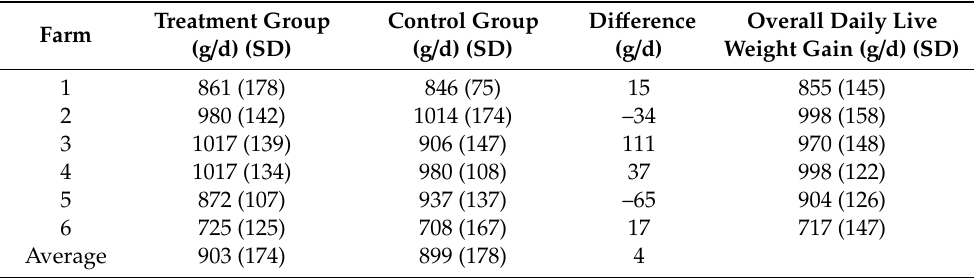
Table A3. Daily live weight gain di ff erences on each farm from six to 12 weeks old. Mathematical means are presented.